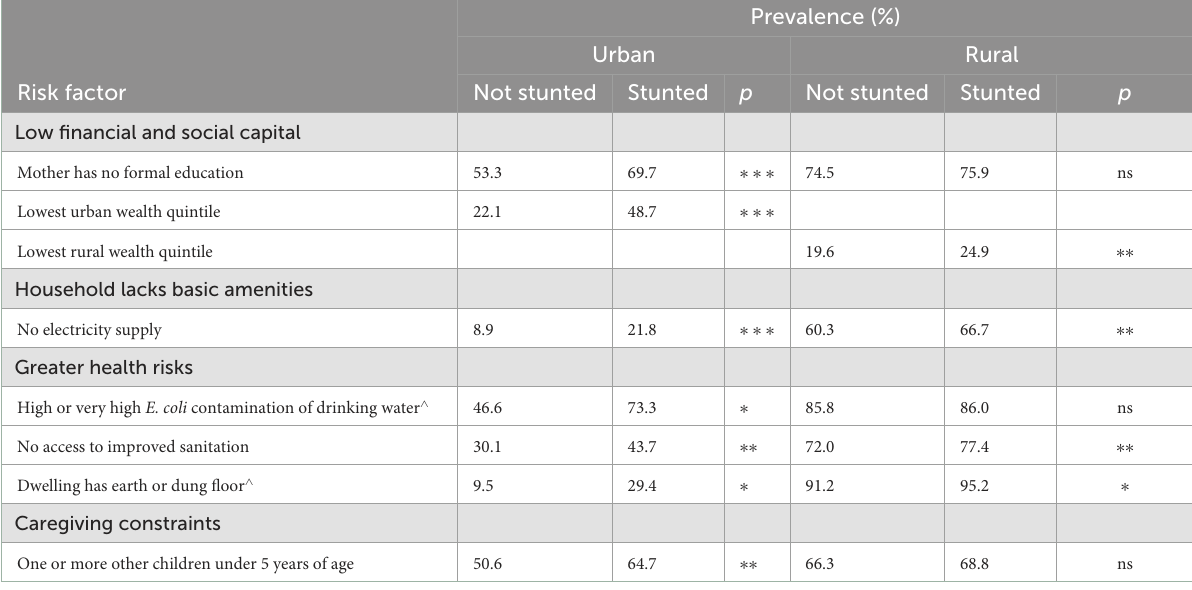
TABLE 3 Association between stunting and exposure to risks to child development among 36- to 59-month-old children living in urban and rural settings in Cote d’Ivoire. Prevalence (%) Urban Rural Risk factor Not stunted Stunted p Not stunted Stunted